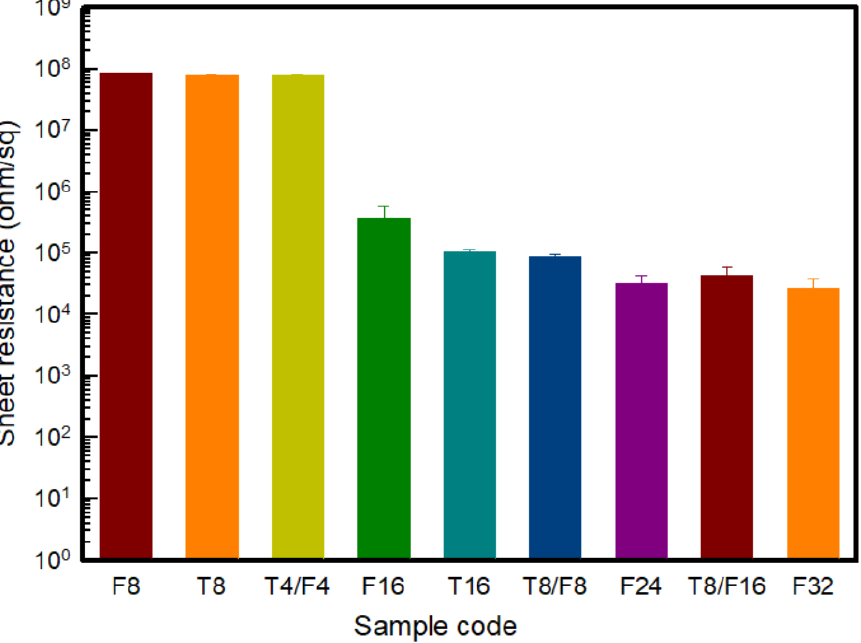
Figure 5. Sheet resistance of the PAN-based composite films with various carbon nanomaterial con- tents.